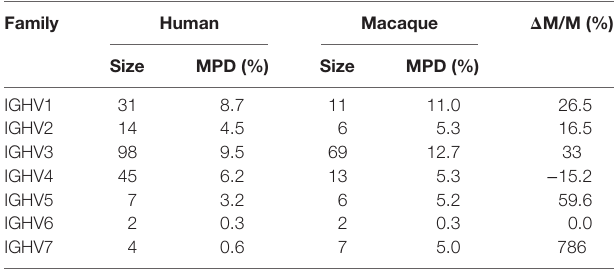
TaBle 5 | Comparison of the mean pairwise distance (MPD) in individual IGHV gene families in human and macaque. Family human Macaque Δ M/M